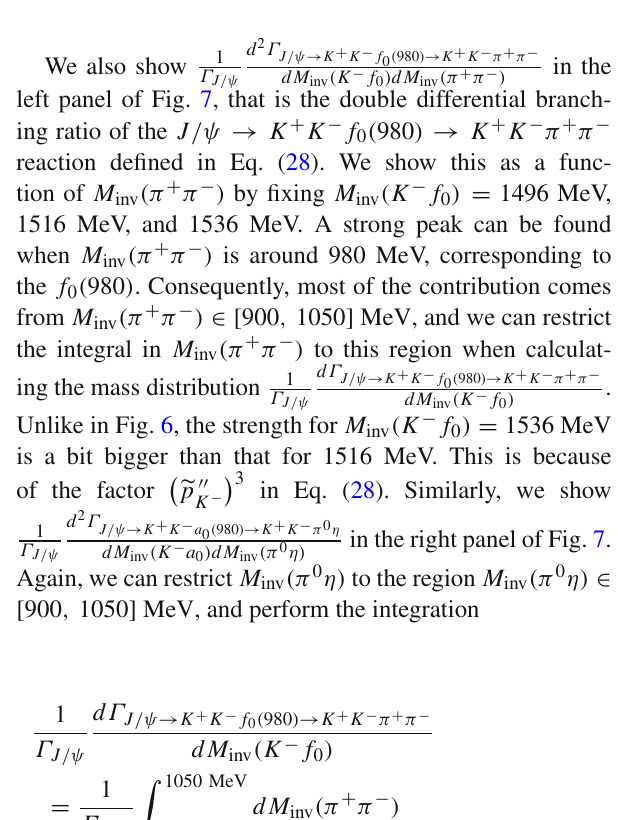
Fig. 5 The differential branching ratio 1 Γ inEq. (21), as a function of M inv ( K − f 0 / K − a 0 ) , for a m f = 987 MeV, c m b m f 0